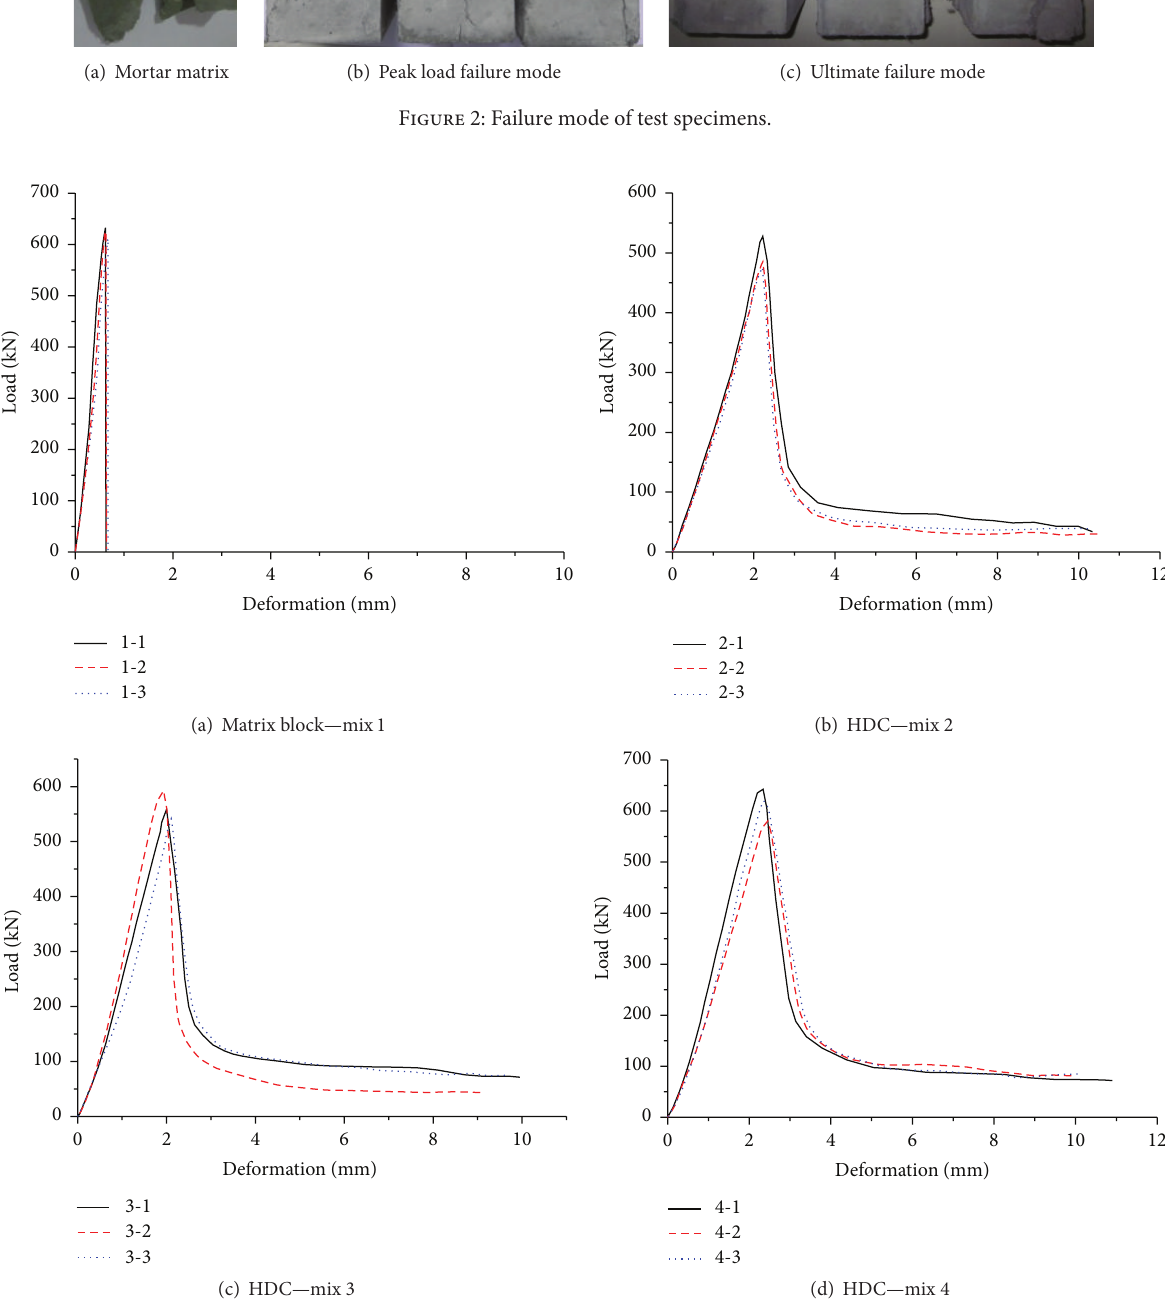
Figure 3: The uniaxial compressive load-deformation curve of test